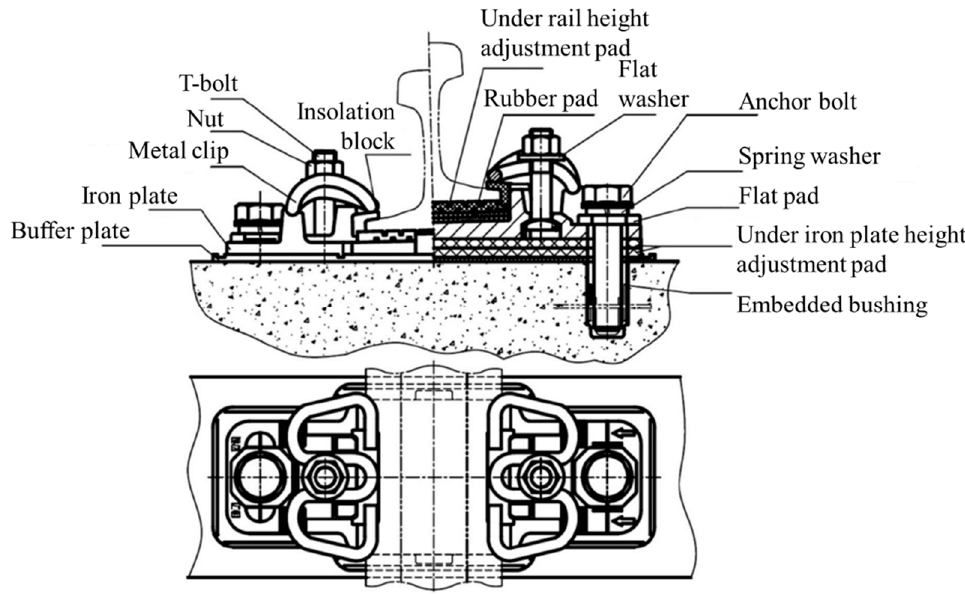
Figure 1. Assembly diagram of the WJ-7 fastening system [6].